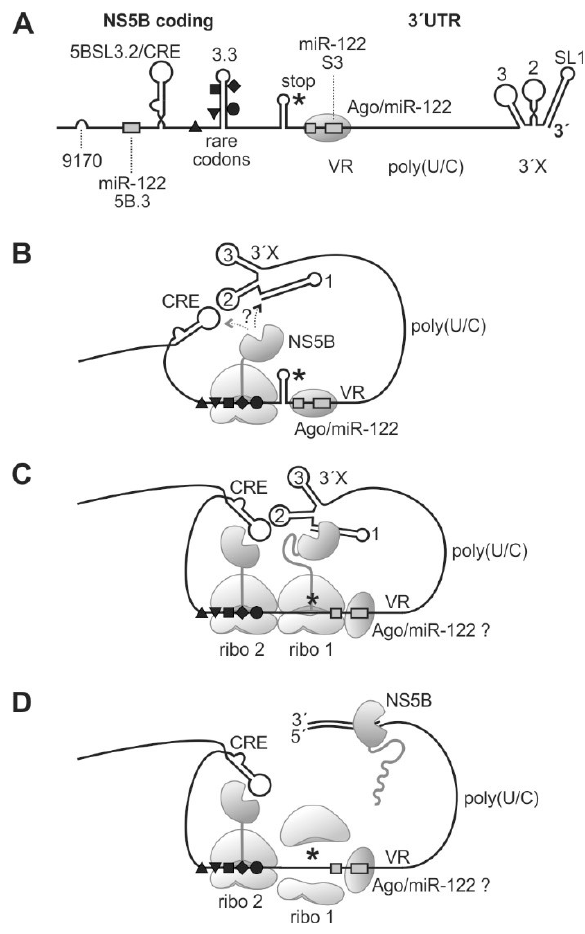
Figure 6. A model for ribosome pausing near the HCV genome stop codon and NS5B binding to the 3 ′ -end of the viral RNA genome. The HCV 3 ′ region ( A ) folds back to allow binding of yet incompletely translated NS5B protein to the SL1 of the HCV 3 ′ end RNA ( B ). When completing NS5B translation ( C ), NS5B starts and proceeds RNA minus strand synthesis ( D ). Black triangles, square, diamond, and circle indicate rare codons as in previous figures. The NS5B stop codon is indicated by an asterisk. VR, variable region; 3 ′ X, 3 ′ X region with highly conserved stem-loops (SL) 1, 2, and 3.